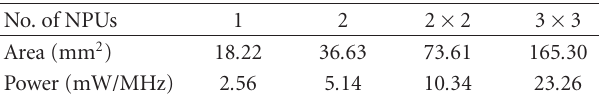
Table 2: Area scalability and power consumption results for 90 nm technology.